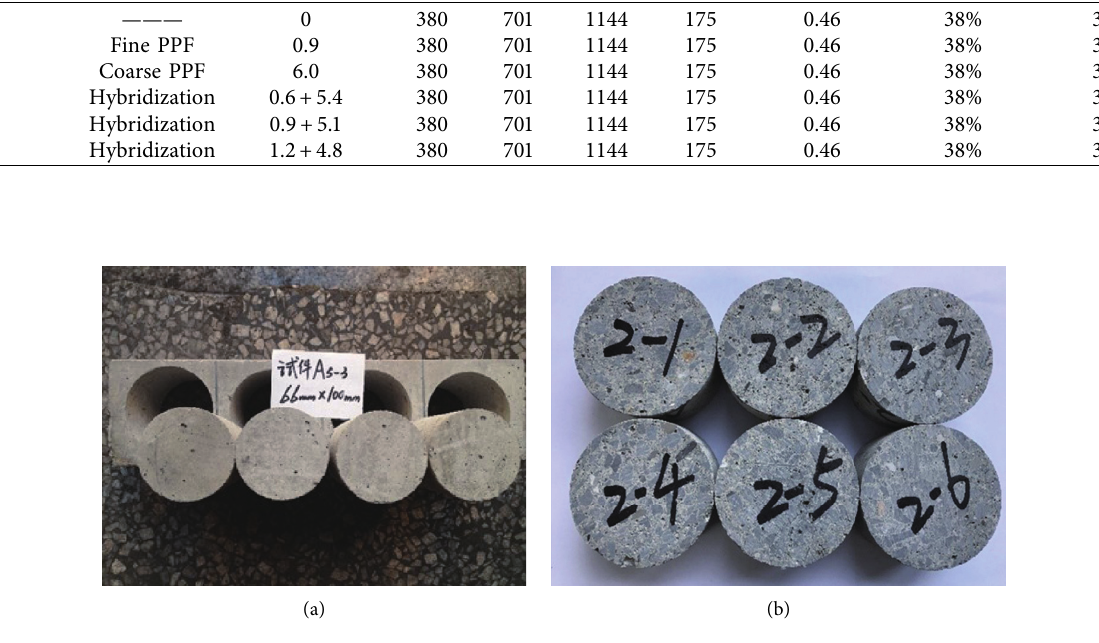
Figure 2: Specimens for SHPB tests: (a) after coring; (b) after cutting and grinding.